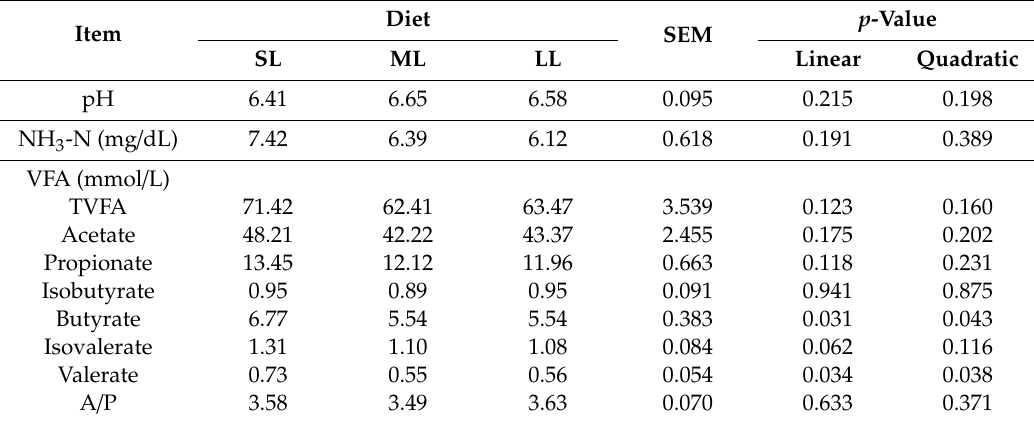
Table 3. E ff ects of roughage length on rumen fermentation of weaned calves.